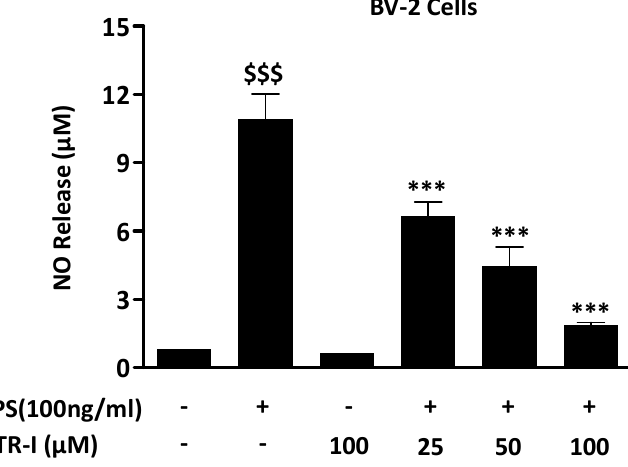
Figure 1. NO release was measured in BV-2 cells ( n = 6) as mentioned in “Material and Methods” section. $$$ p < 0.001 vs. vehicle group and *** p < 0.001 vs. LPS group.